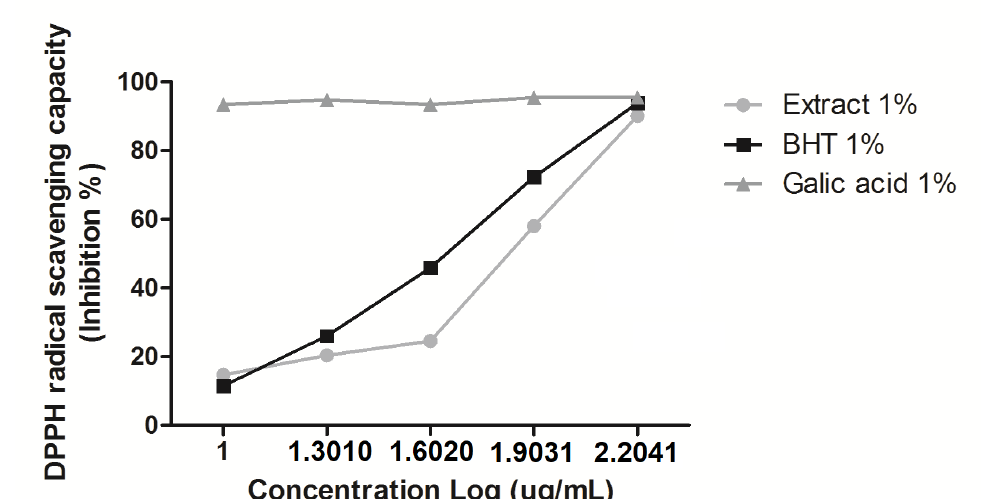
FIGURE 5 - Evaluation of the in vitro antioxidant activity of the Coffea Arabica L. leaf ethanolic extract by the DPPH radical scavenging assay. Data were expressed as the mean of triplicate ± standard deviation (SD), performed in independent days. Different letters in same column indicate significance at p < 0.05. DPPH: 2,2-diphenyl-1-picrylhydrazyl, BHT: 3,5-Di-tert-4-